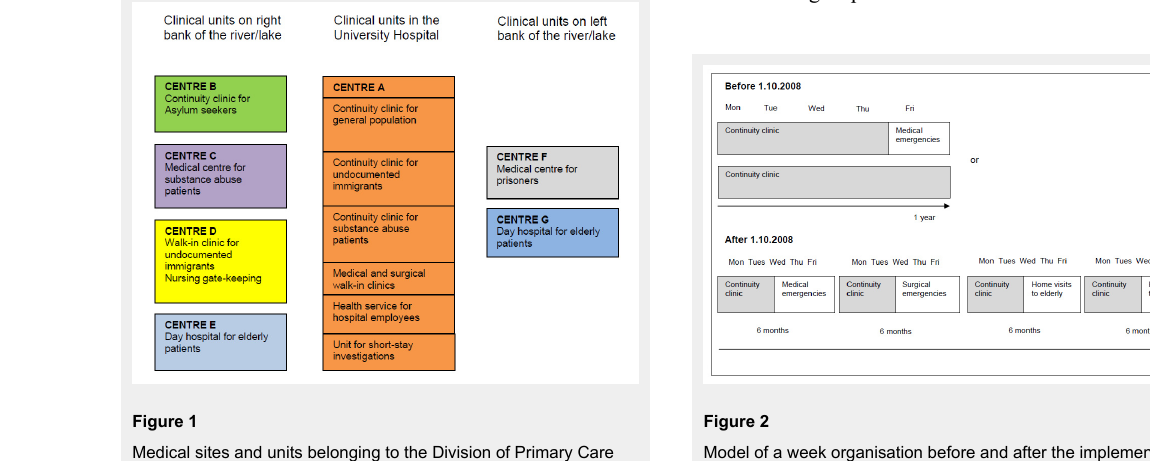
Model of a week organisation before and after the implementation of the new